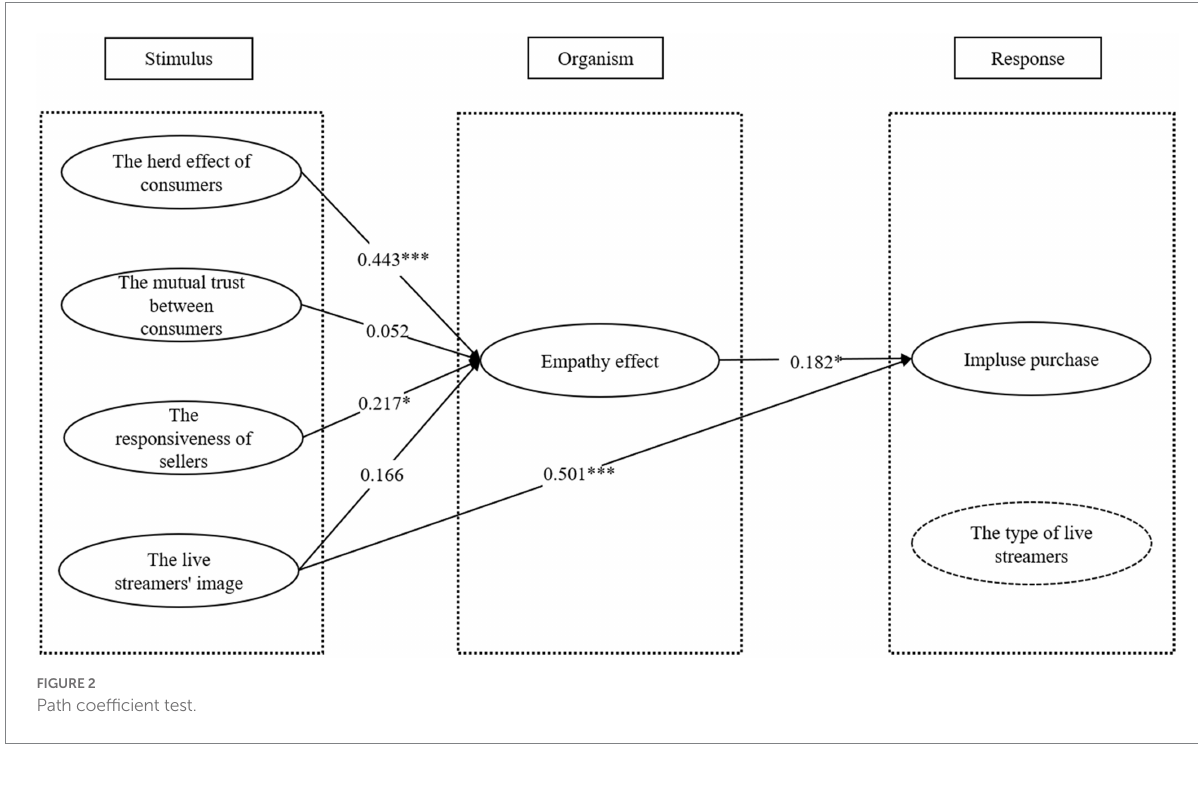
TABLE 7 Modified model fit test.